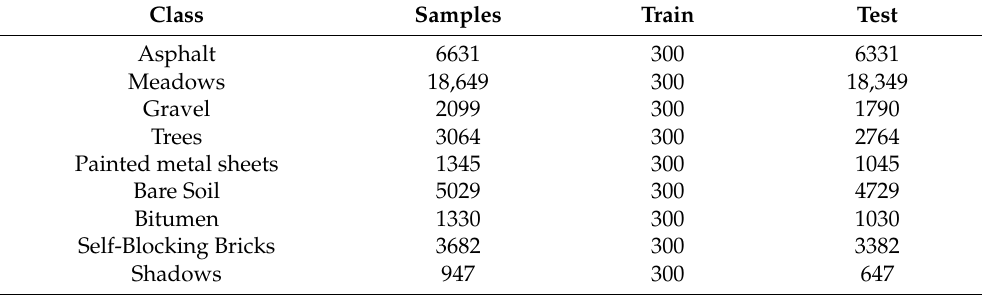
Table 5. Ground truth classes for the Pavia University scene and their respective numbers of